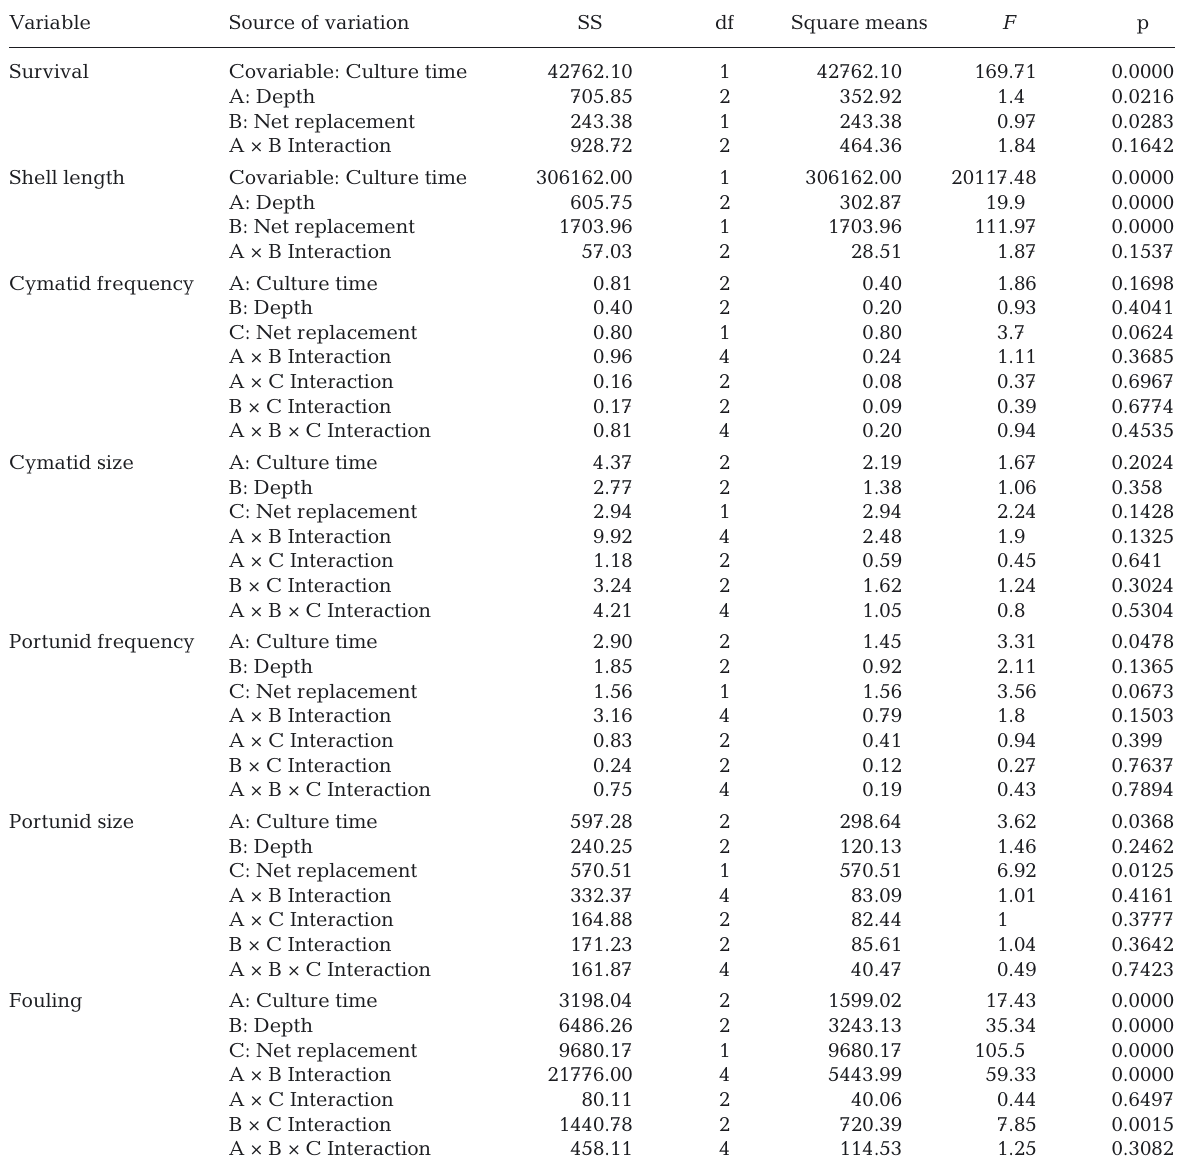
Table 1. ANCOVAs and ANOVAs of the survival and shell length of Argopecten nucleus and Nodipecten nodosus maintained at different suspended culture conditions (i.e. culture depths and net replacement